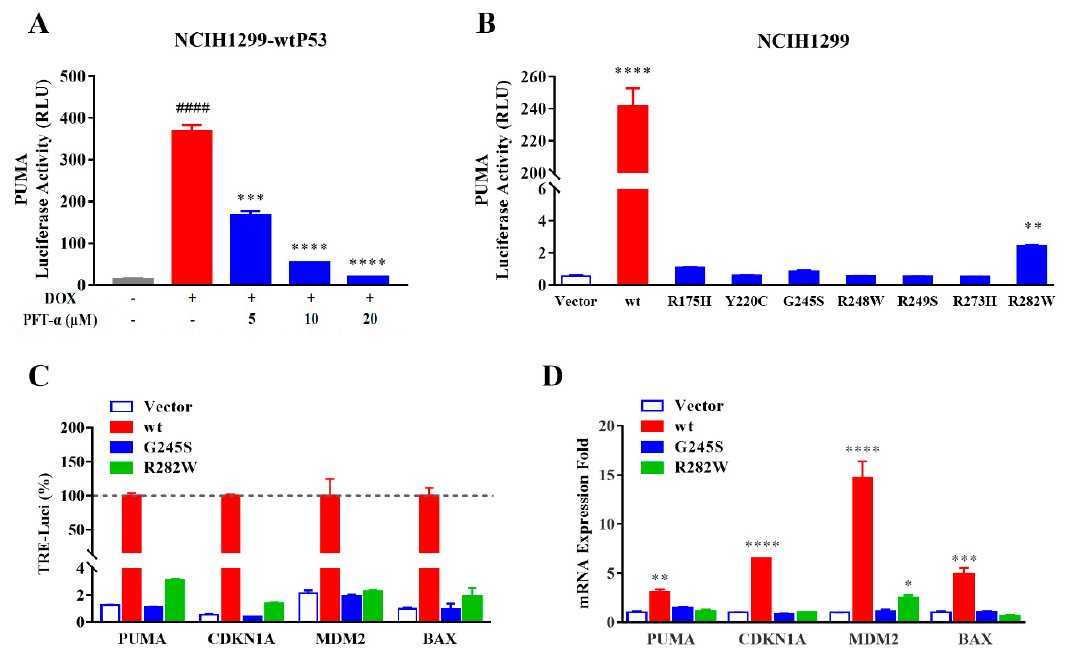
Figure 3. Activity status of P53 correctly reflected by improved reporter gene system. ( A ) Activation of the TRE of PUMA by wtP53 (red), P53 inhibitor PFT ‐α reduced the reporter gene signal in a dose ‐ dependent manner (blue) ( n = 3). ( B ) Induction of PUMA reporter gene by wtP53 (red) and mutP53 (blue) ( n = 3). ( C ) Using reporter gene with P53 ‐ TRE of four target genes ( PUMA , CDKN1A , MDM2 , and BAX ) to measure the effect of different P53 statuses ( n = 3). ( D ) RT ‐ qPCR assay of the four target genes in corresponding samples of ( C ) ( n = 3). Data are presented as the mean ± S.D. obtained from three separate experiments. Compared to the non ‐ DOX group in ( A ), #### p < 0.0001; compared to the DOX but non ‐ PFT ‐α group in ( A ), *** p < 0.001 and **** p < 0.0001; compared to the corresponding vector group, * p < 0.05, ** p < 0.01, *** p < 0.001, and **** p < 0.0001.